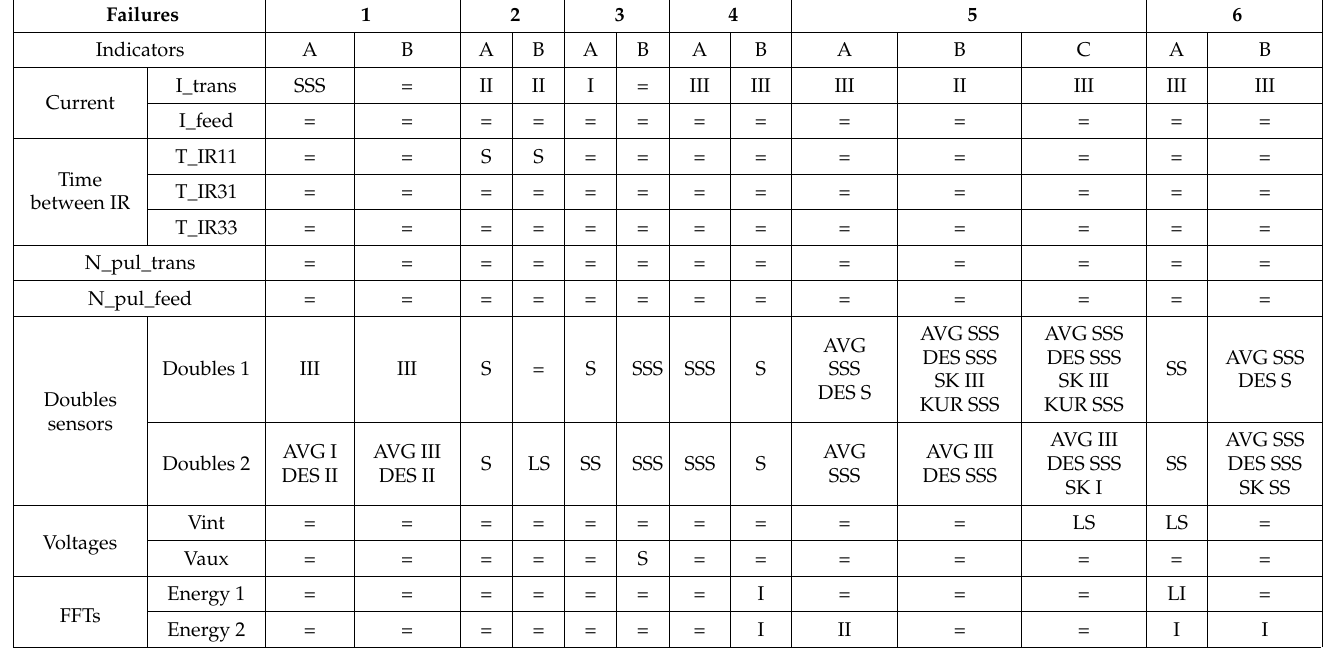
Table 4. Summary of the information of the indicators of interest in each